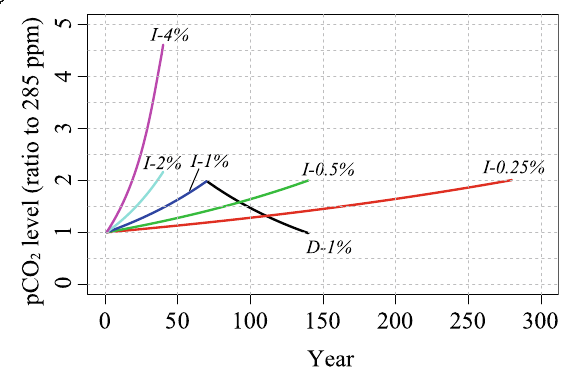
Fig. 1 Plots of pCO 2 levels against time (years) for the various study scenarios: I - 1 % (dark blue line); I - 0.5 % (green line); I - 0.25 % (red line); I - 2 % (light blue line); I - 4 % (Purple line); D - 1 % (black